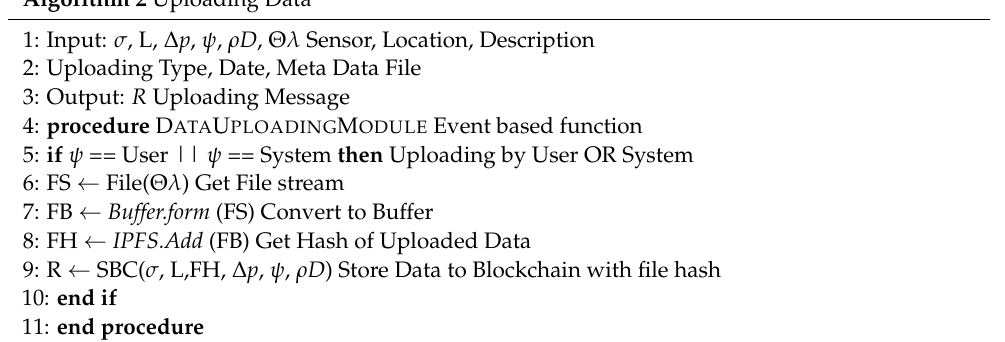
Algorithm 2 Uploading Data